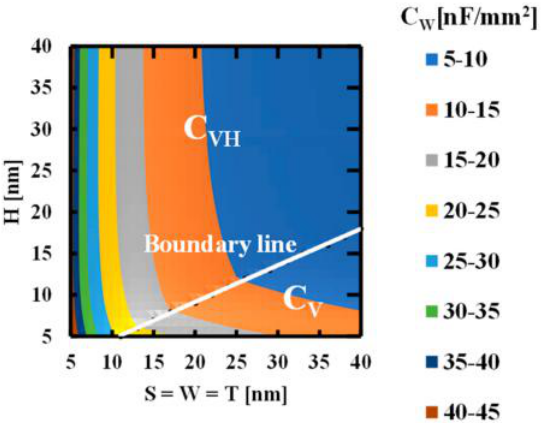
Figure 8. Contour plot of wring capacitance across the H - S plane in case of M = 5.